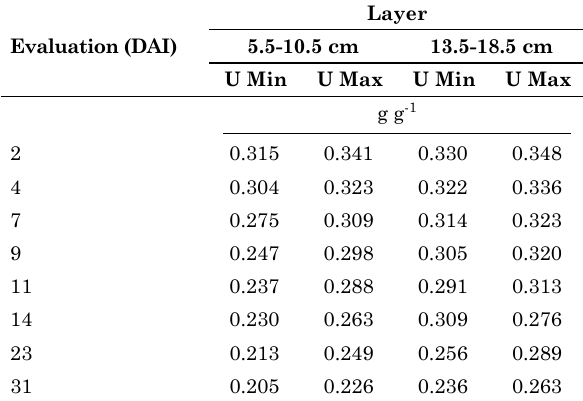
table 1. range of variation of gravimetric water content in the soil (u) for each evaluation of soil resistance to penetration, measured